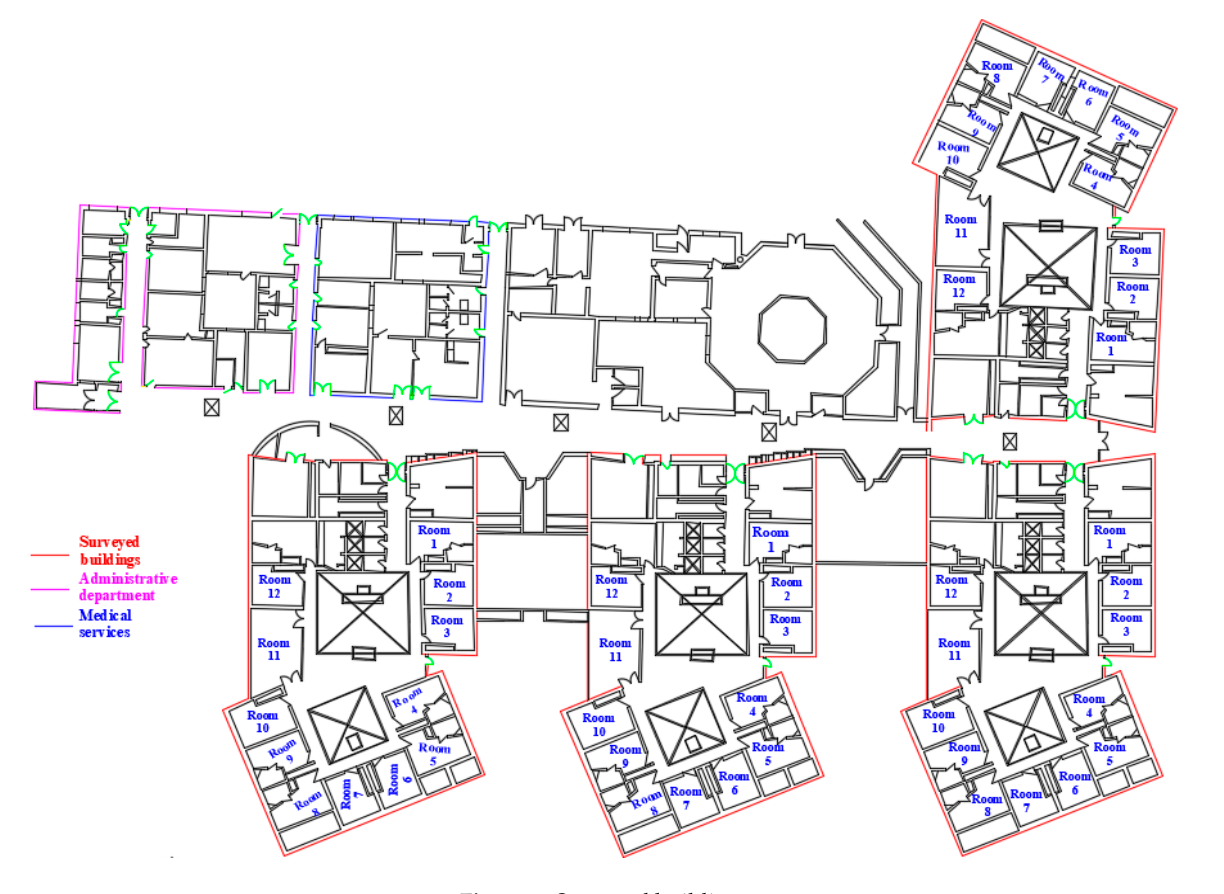
Figure 2. Locations of the survey sites.